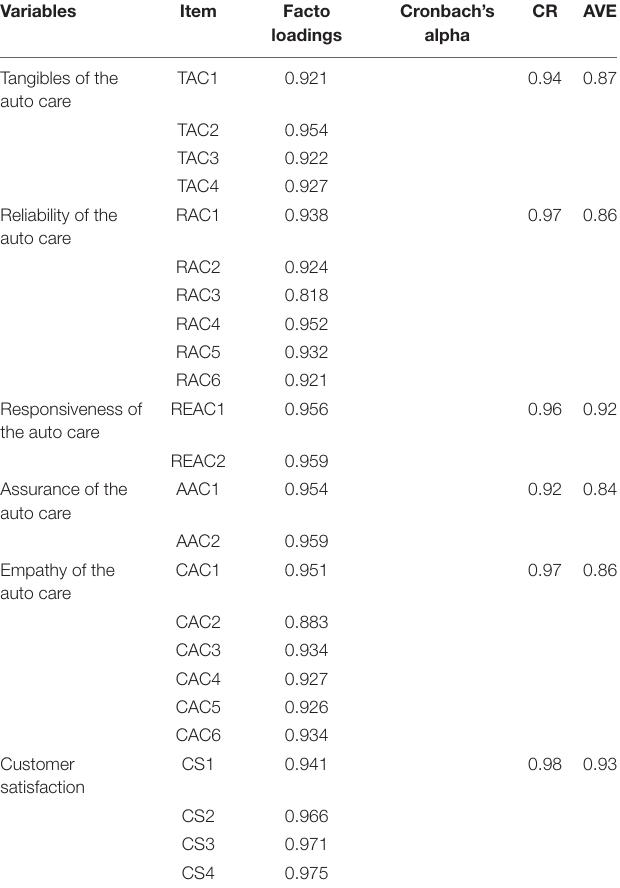
TABLE 3 | Item loadings, Cronbach’s alpha, composite reliability, and average variance extracted.